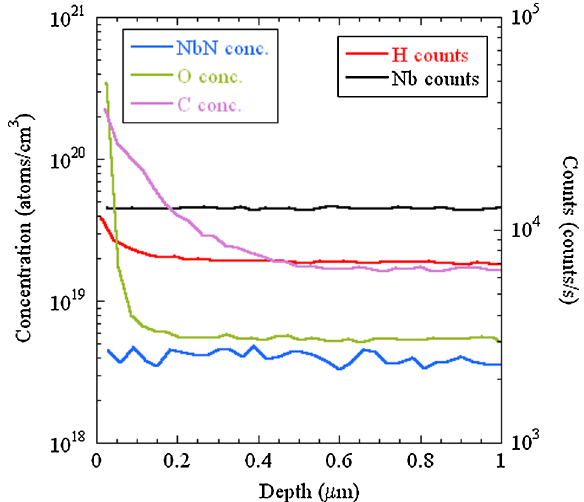
FIG. 19. (Color) SIMS reduced data depth profile for the heat treated sample L16. The heat-treatment parameters are , 120 (cid:1) C = 6 h (see Table 800 (cid:1) C = 3 h , 400 (cid:1) C = 20 min with N 2